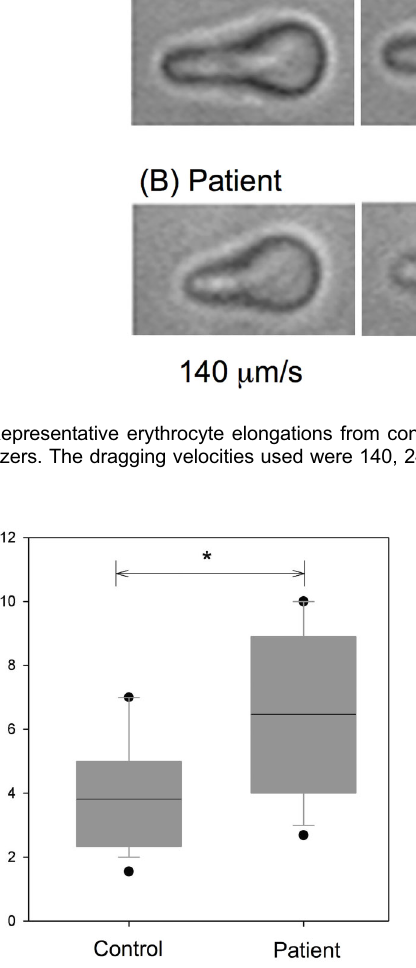
Figure 2. Box plot of erythrocyte elasticity for controls and patients with leptospirosis. The black lines represent the median of the elastic constant of erythrocyte for control and patients with leptospirosis. *P o 0.05 (Mann-Whitney